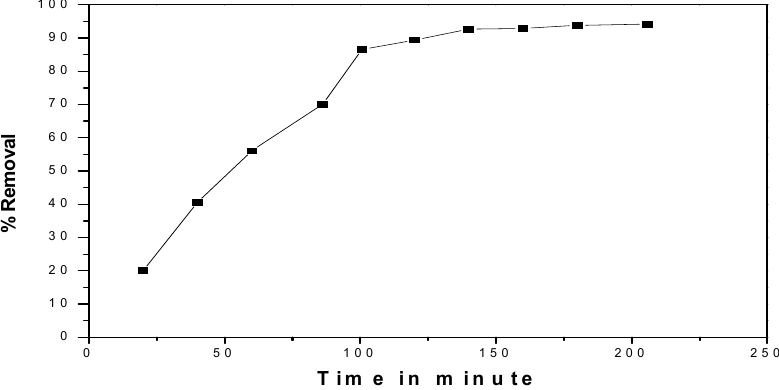
Fig.9. Effects of contact time on Pb(II) ions removal.